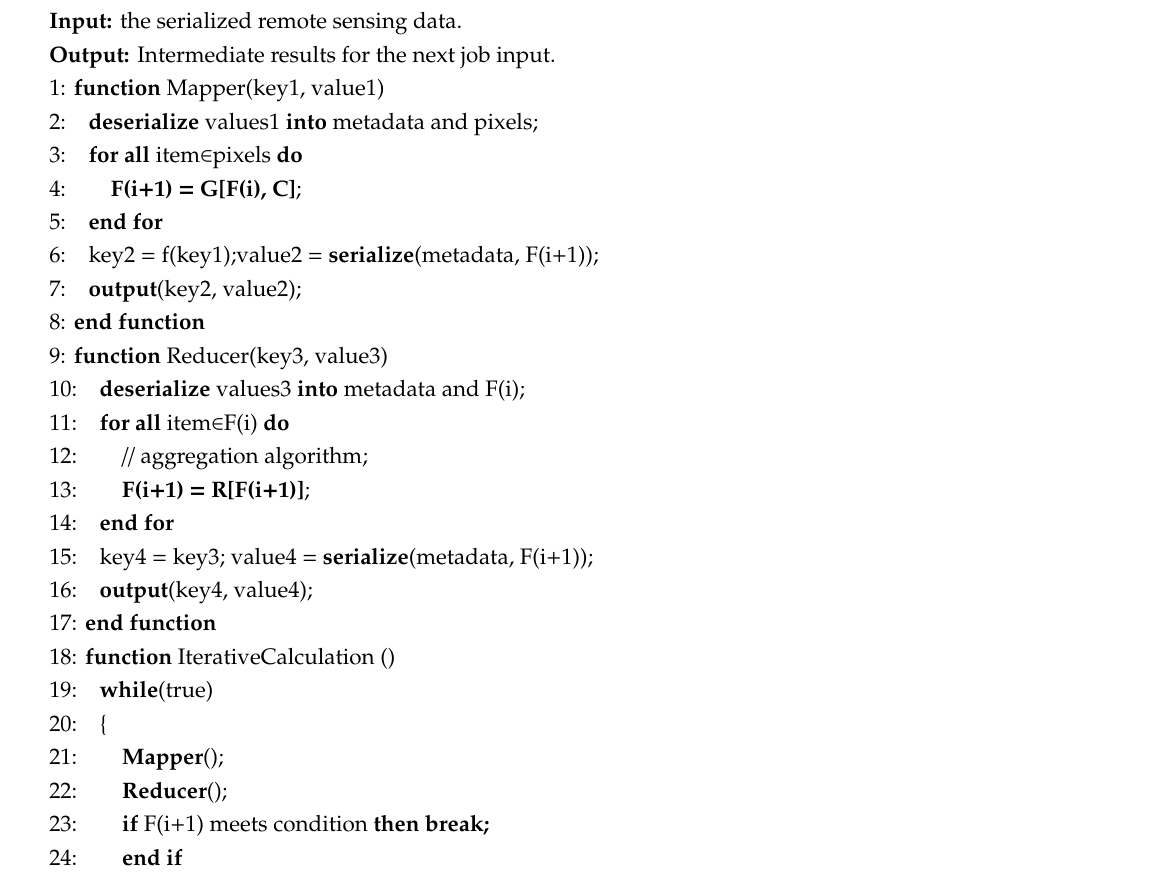
Algorithm 2: The cloud computing model for Iterative